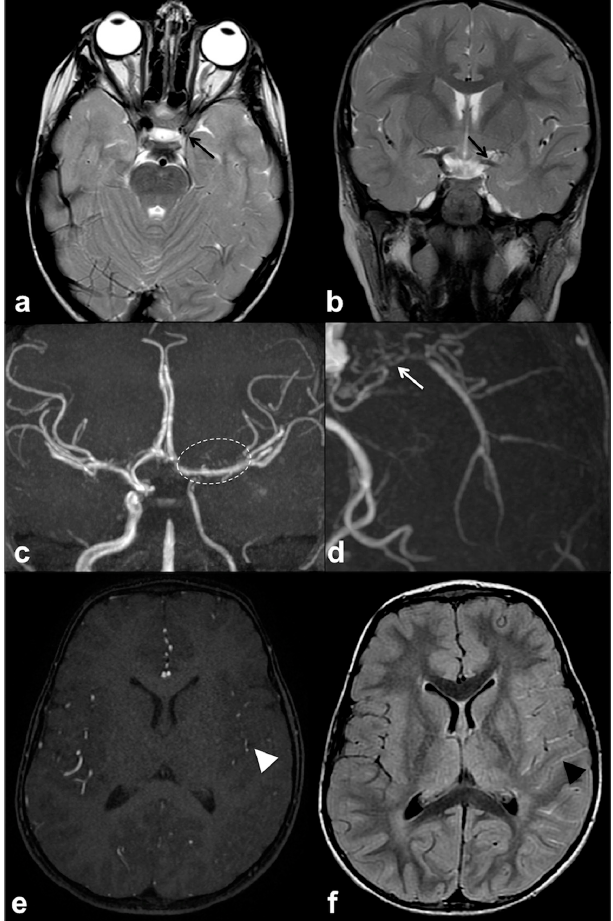
Figure 5. Axial ( a ) and coronal ( b ) TSE T2w MRI of an 8 year-old girl with NF1, showing reduced visualization of left cavernous-supraclinoid internal carotid and proximal left middle cerebral arteries’ flow void (black arrows). Time-of-flight 3D MR angiography maximum intensity projection ( c ) confirmed the severe stenosis of left internal carotid artery and proximal segment of left middle cerebral artery, whereas distal segments are partly supplied by collaterals; dotted line region magnification ( d ) showed multiple small collateral vessels in proximal left middle cerebral artery region (white arrow). Axial time-of-flight 3D MR angiography ( e ) confirmed a reduction in distal middle cerebral artery branches flow (white arrowhead), with a diffuse net of prominent leptomeningeal collaterals with high signal on FLAIR ( f ) due to slow flow (black